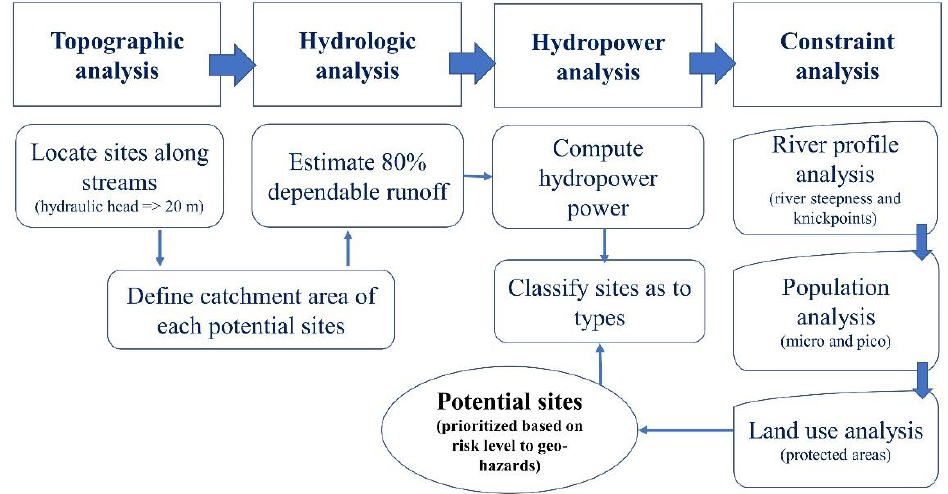
Figure 1. General workflow of the identification of potential small-scale hydropower sites.